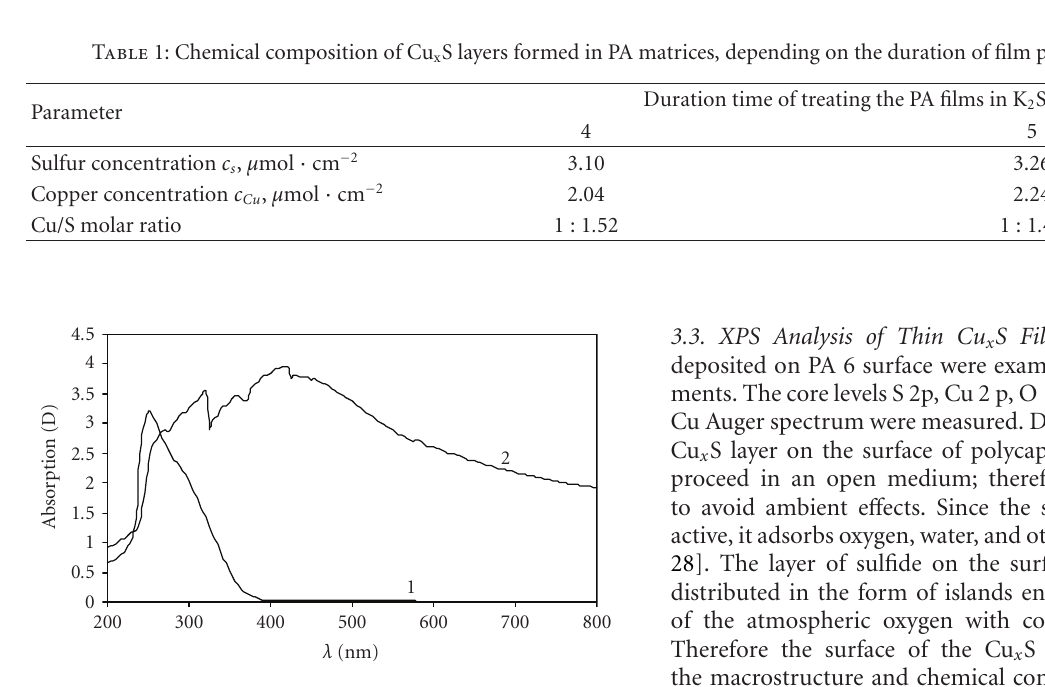
Figure 1: Typical UV/VIS absorption spectra: (1) of the layers of PA 6 sulfured for 5 hours in 0.15 mol · dm − 3 K 2 S 5 O 6 at 20 ◦ C, (2) of the layers then treated with Cu(I)